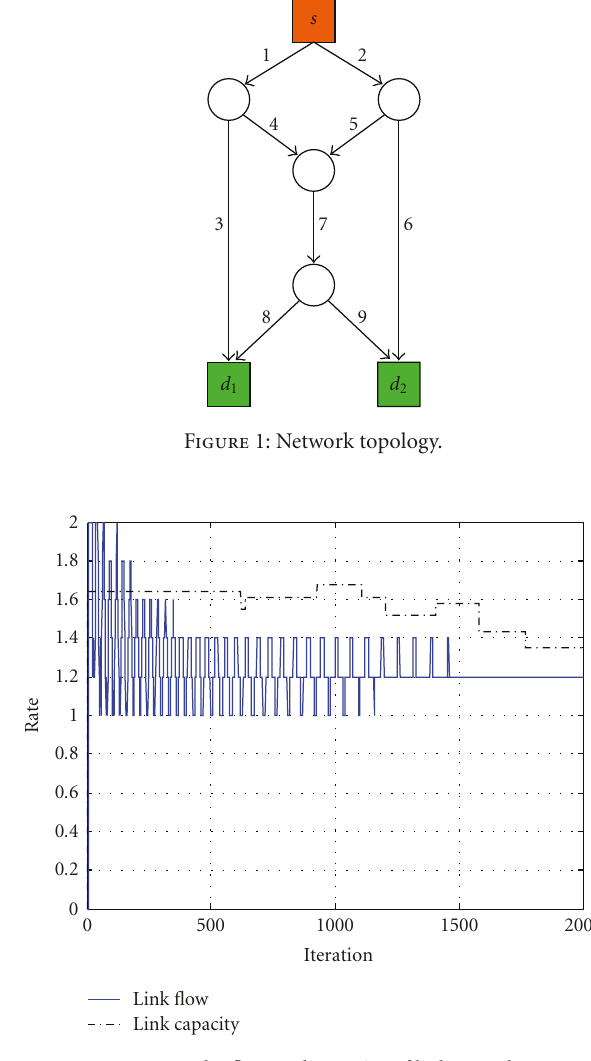
Figure 2: The flow and capacity of links 1 and